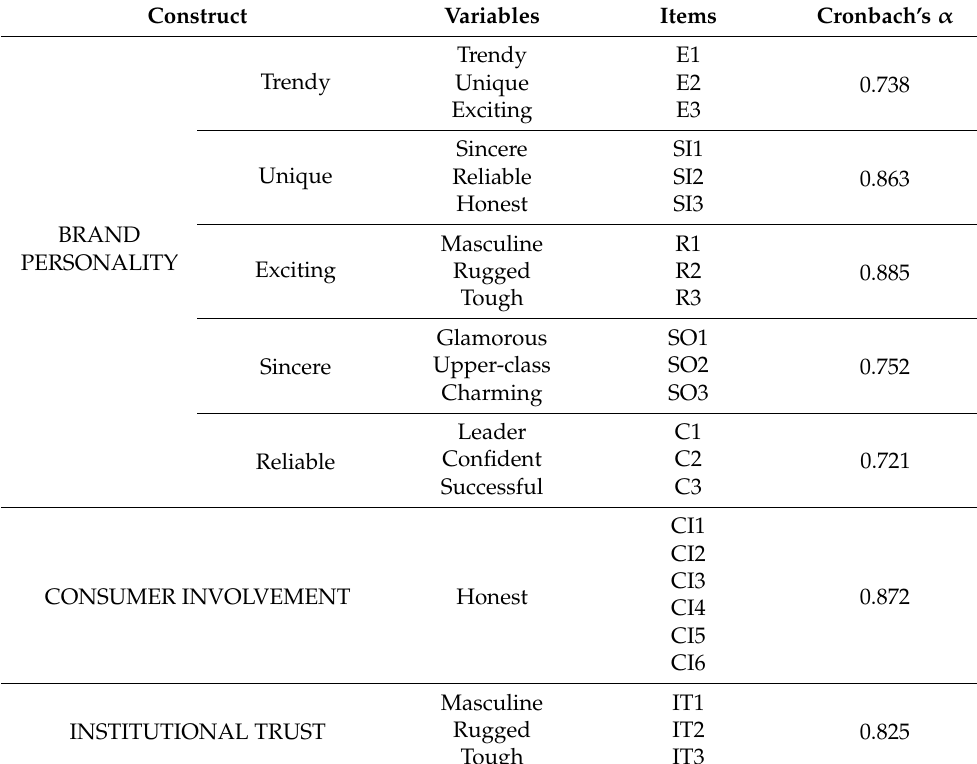
Table 3. Construct reliability.